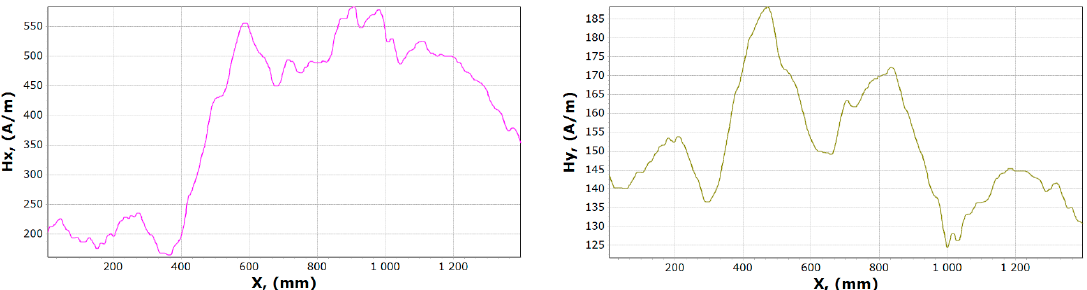
Figure 10. Graphs of tangential Hx and normal Hy component of magnetic field, for sample 15.